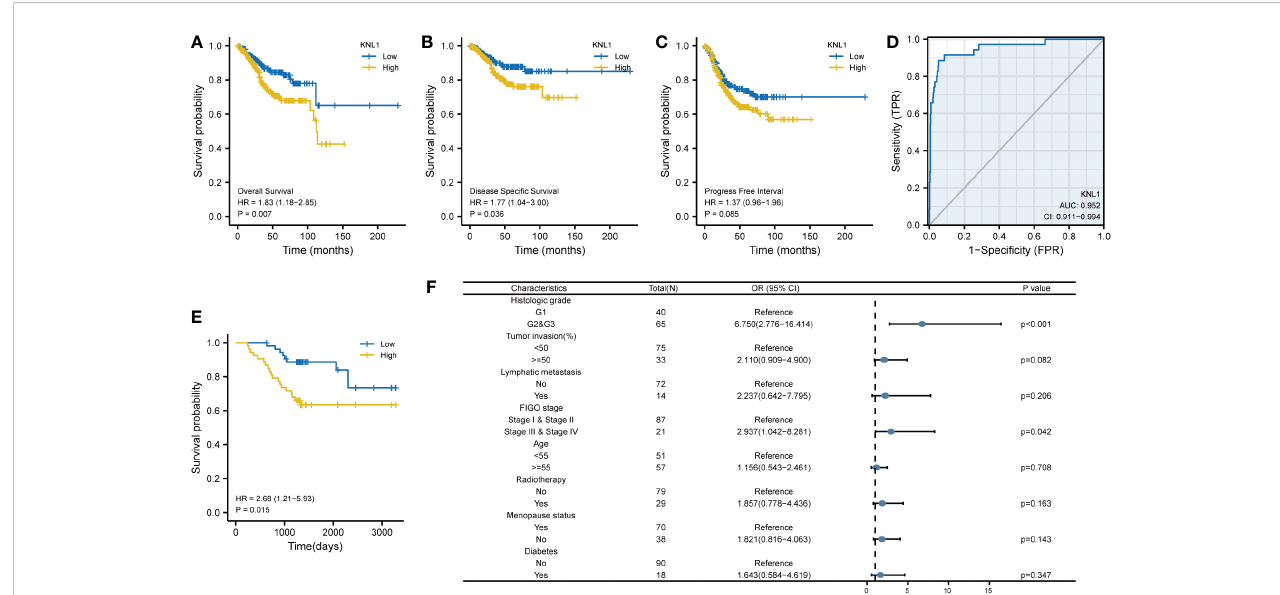
FIGURE 7 Correlation of KNL1 expression with the outcomes of UCEC patients. (A – C) KM survival curves strati fi ed by KNL1 expression for overall survival (OS), disease-speci fi c survival (DSS), and progression-free interval (PFI). (D) Prognostic ROC curve; the area under the ROC curve was between 0.5 and 1. The closer the AUC is to 1, the better the diagnostic effect is. The AUC has a low accuracy when it is between 0.5 and 0.7, a moderate accuracy when it is between 0.7 and 0.9, and a high accuracy when it is above 0.9. (E) KM OS curves strati fi ed by KNL1 expression of 108 clinical samples of UCEC. (F) Results of binary logistic regression analysis of the correlation between the KNL1 expression level and the clinical characteristics of the 108 patients. The data were incomplete, as some records were lost.